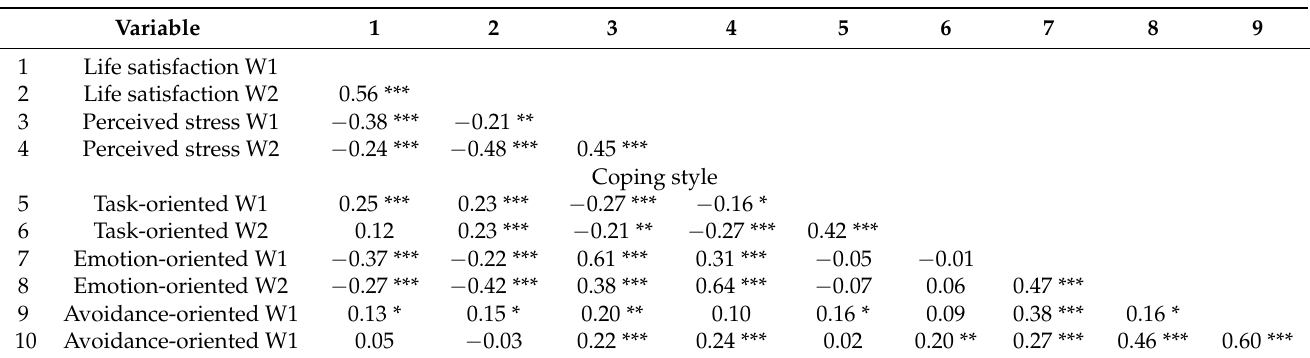
Table 3. Correlations matrix for all variables in W1 and W2 of the COVID-19